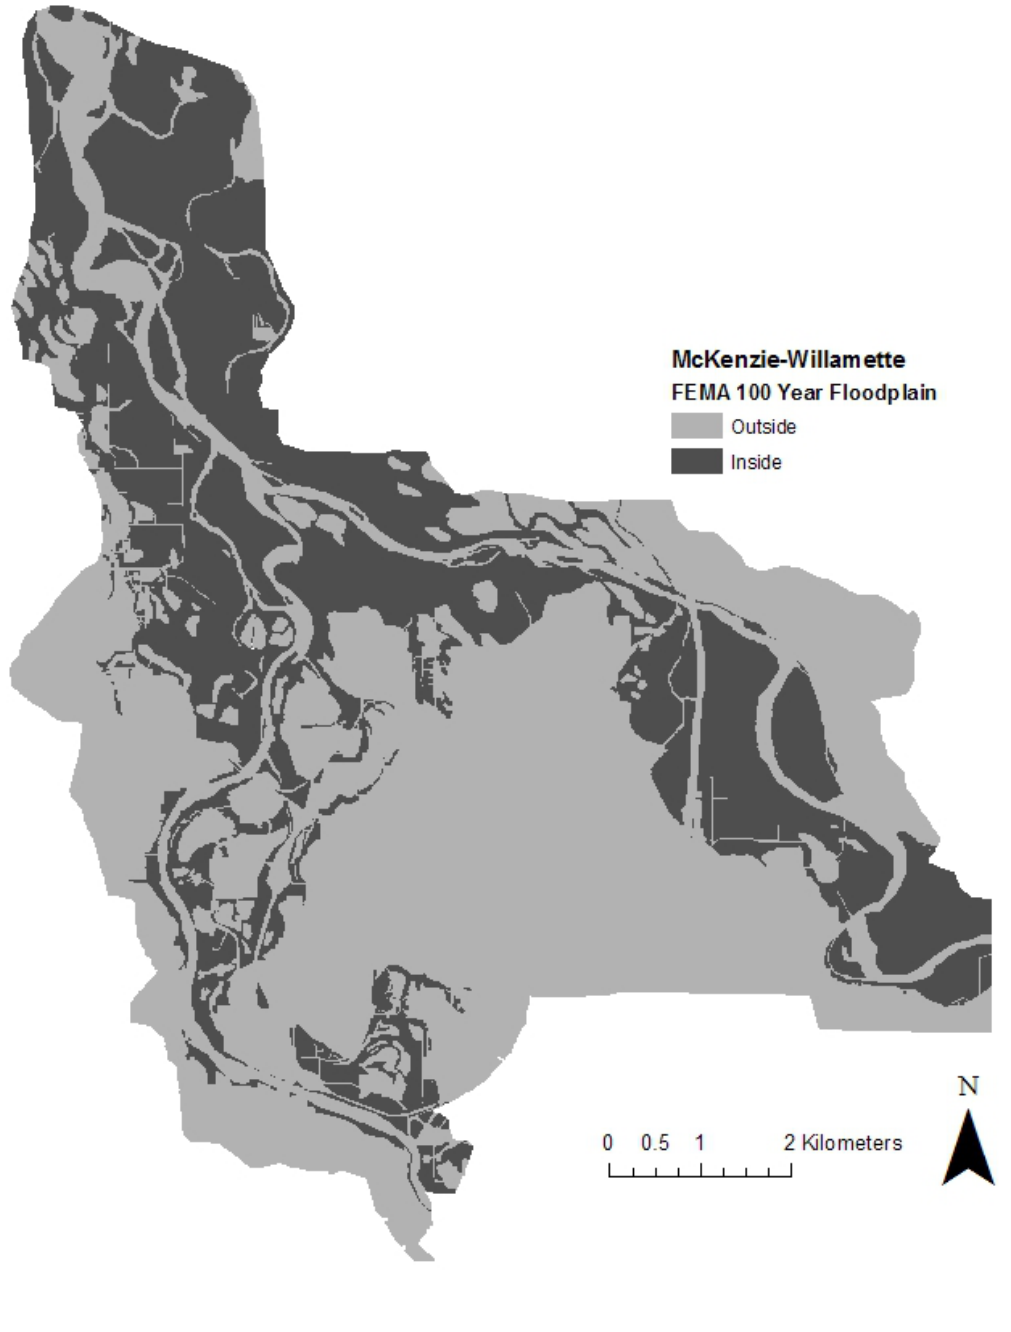
Fig. 7 . The Federal Emergency Management Agency 100-yr flood plain is dark